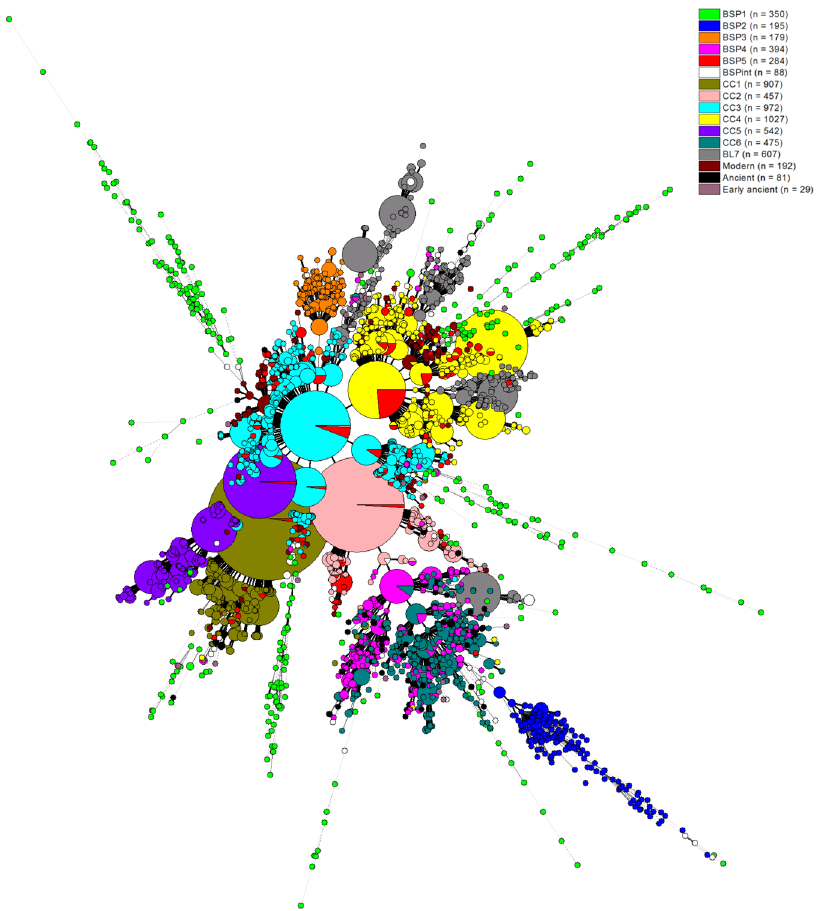
Figure 3. A minimum spanning tree (MST) based on pooled data on Beijing isolates (n = 6779 strains). The combined MST highlights evolutionary relationships of different Beijing groups from the present study on BSP groupings (BSP1 n = 350, BSP2 n = 195, BSP3 n = 179, BSP4 n = 394, BSP5 n = 284, BSPint n = 88; total 1490 strains), classification of a series of clonal complexes (CCs) defined by Merker et al . 19 in a global study (CC1 n = 907, CC2 n = 457, CC3 n = 972, CC4 n = 1027, CC5 n = 542, CC6 n = 475, BL7 n = 607; total n = 4987 strains), and a recent study describing 3 groups based on evolutionary history of Beijing isolates in China countrywide by Yin et al . 20 , as Modern n = 192, Ancient n = 81, Early ancient n = 29; total n = 302 strains); the complexity of the lines denotes the number of allele/spacer changes between two patterns: solid lines (1 or 2 or 3 changes), gray dashed lines (4 changes) and gray dotted lines (5 or more changes); the size of the circle is proportional to the total number of isolates sharing same